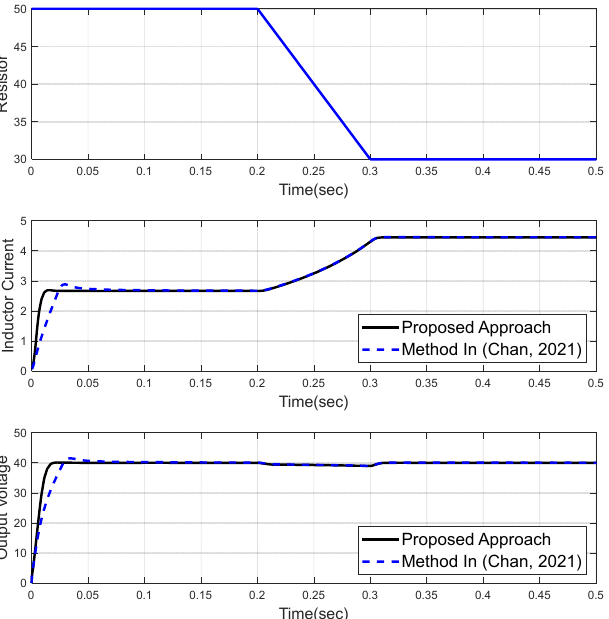
Figure 7. Comparison of the behaviour of the inductor current and output voltage with the results of the method in Ref. [1] in case of resistance changes.